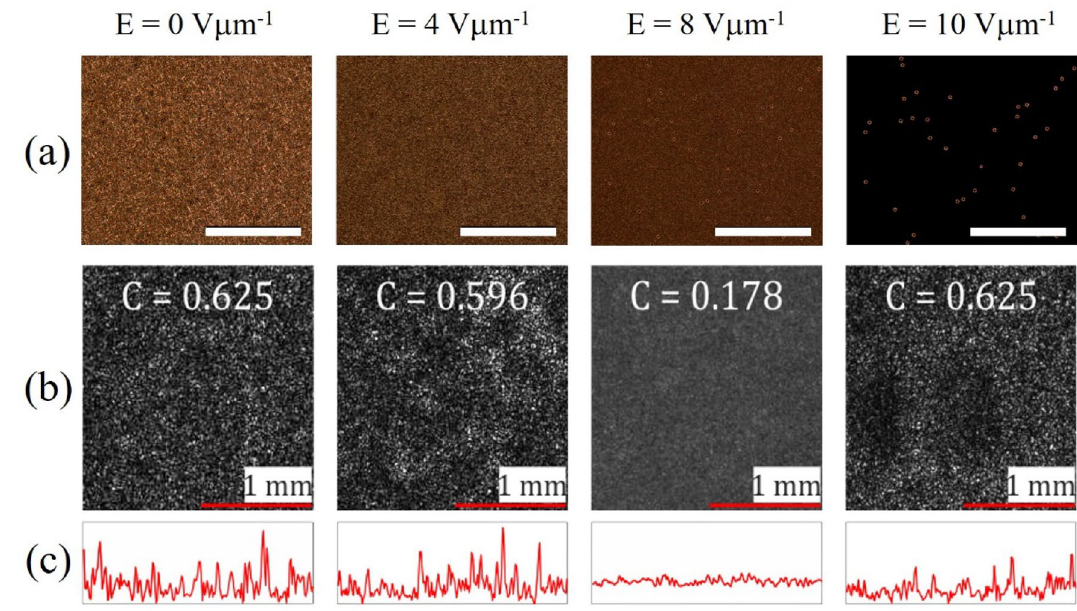
Figure 1. Speckle reduction characteristics of a chiral nematic LC device (E7 + 2.5 wt% BDH1281, pitch 517 nm) when subjected to different amplitudes of a square-wave electric field at a frequency of 40 Hz ( a ) Optical polarising microscope images of the LC device (the 20 μm-diameter spacer beads can be seen in all images, although they are most obvious for the image recorded at E = 10 Vµm −1 ). Scale bars are 500 µm. ( b ) Corresponding images of the speckle pattern formed on a white screen after the beam from a He–Ne laser has passed through the LC device. The same electric field is applied as those used in ( a ). Images were captured by the CCD camera with a 50 ms exposure time and normalized by the average intensity. ( c ) Plots of the intensity distribution of the central line of pixels across the width of each image of the speckle pattern presented in ( b ). All measurements were carried out at 25 °C using a 20 µm-thick